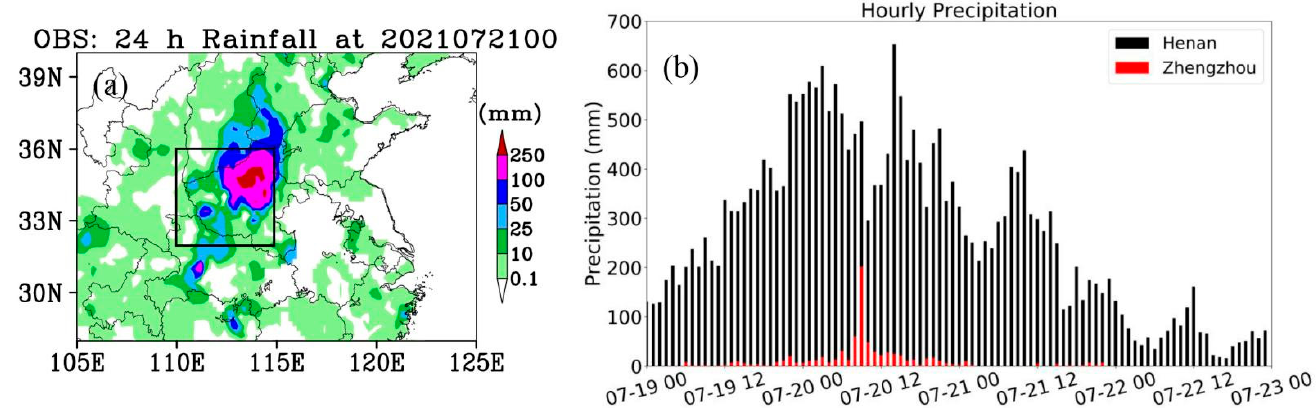
Figure 2. ( a ) The 24-h accumulated precipitation observed on 20 July 2021 and ( b ) hourly precipitation observations for Zhengzhou station and the whole of Henan Province.